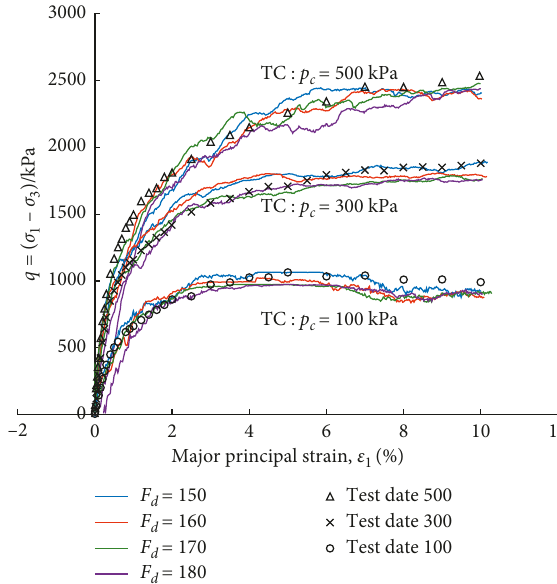
Figure 19: Effect of the particle angularity on the shear